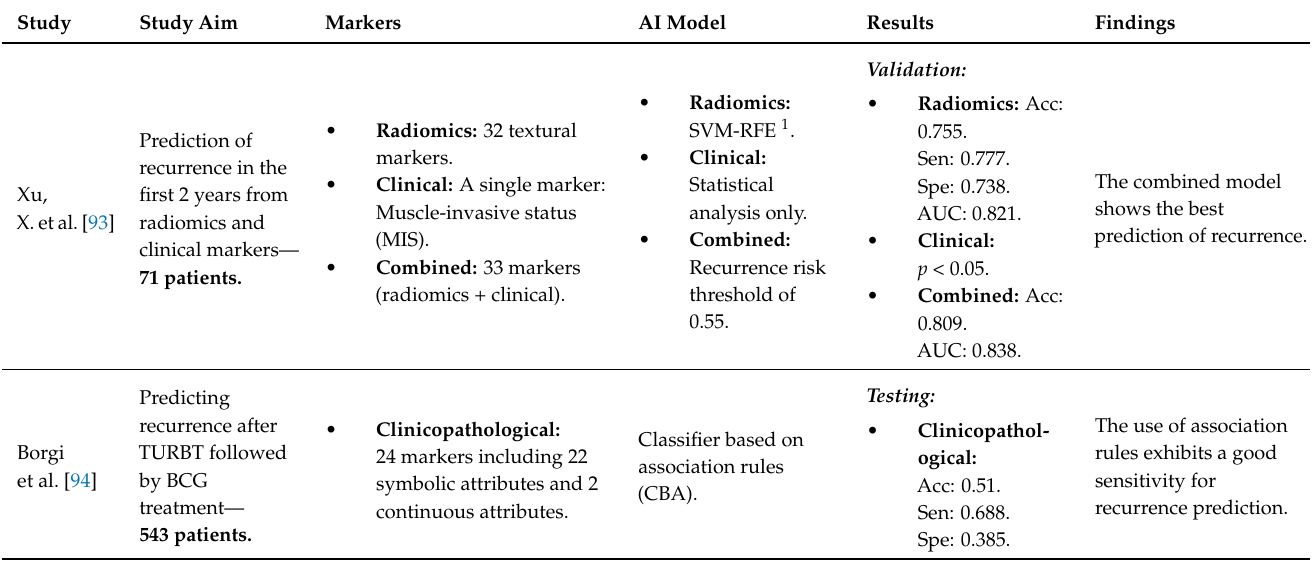
Table 5. Literature review on using combined markers to predict recurrence in